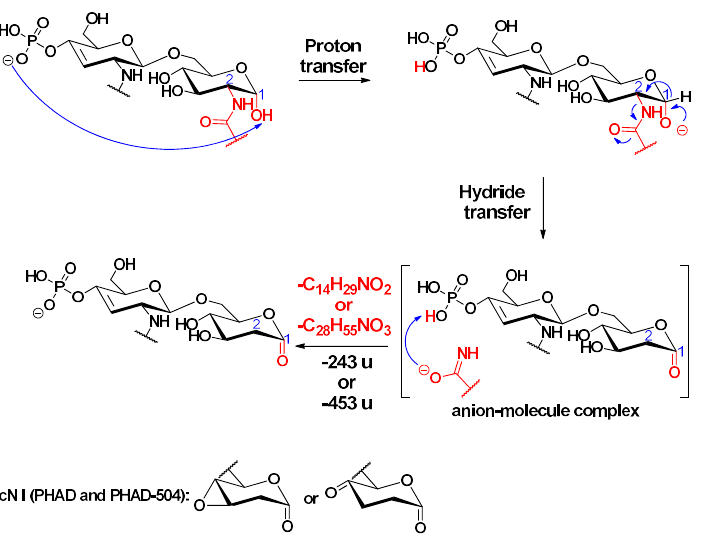
Scheme 10. Proposed fragmentation mechanism leading to the release of the residual C-2’ primary fatty acid as ketene.